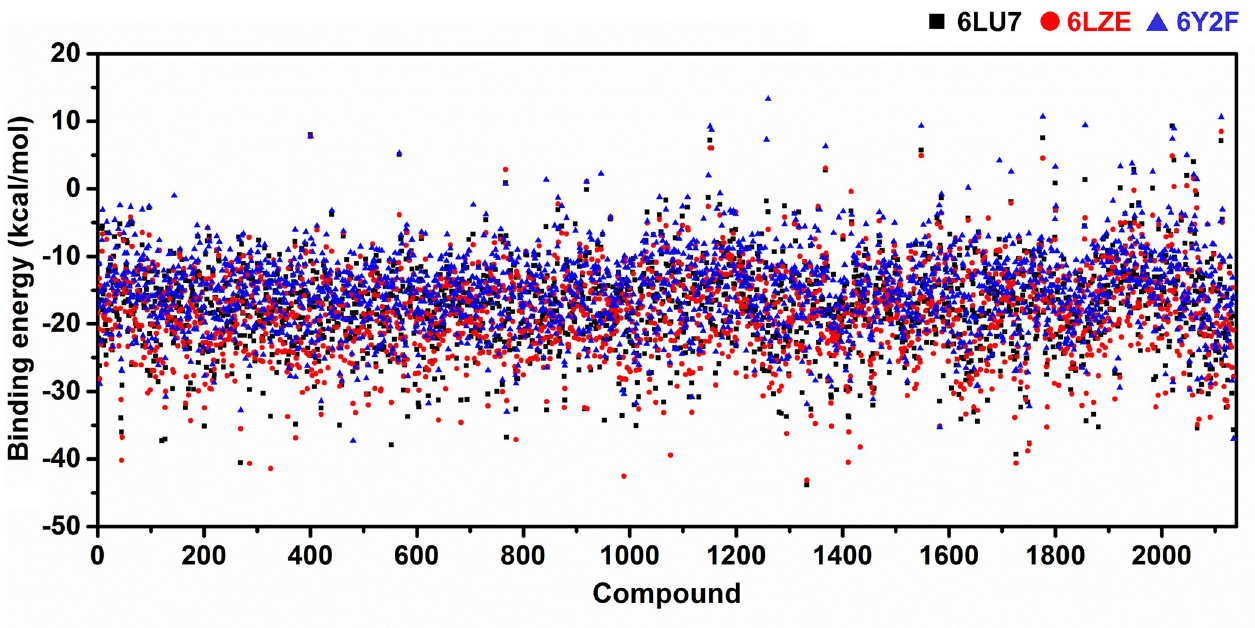
Fig 2. Binding energy (kcal/mol) of approved drugs against three X-ray structures of SARS-CoV-2 3CL pro (PDB entry codes: 6LU7, 6LZE, and 6Y2F) derived from molecular docking.